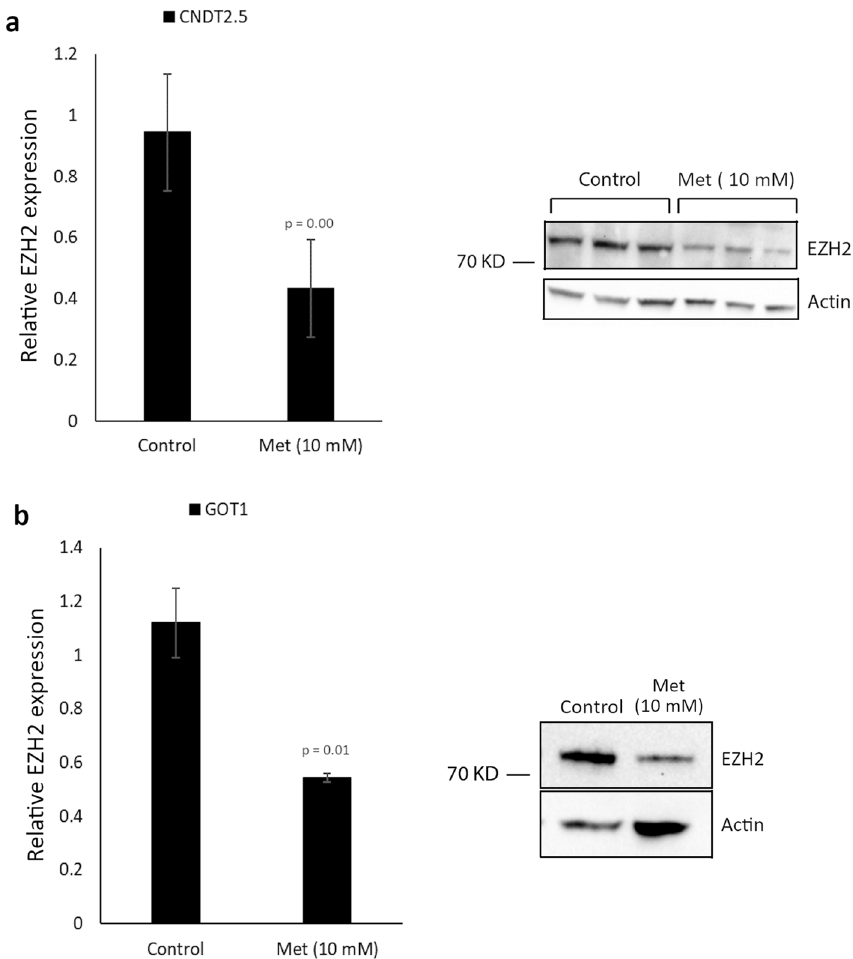
Figure 5. Metformin treatment reduced expression of EZH2 in SI-NET cells. ( a ) Reduced expression of EZH2 in CNDT2.5 cells after 48 h. Western blot analysis is presented for triplicates. ( b ) Reduced EZH2 expression in GOT1 cells after 72 h. Western blot analysis is presented for a pooled lysate of triplicates. Full-length blots are found in Supplementary Figure S1. Data presented are means ± SD of